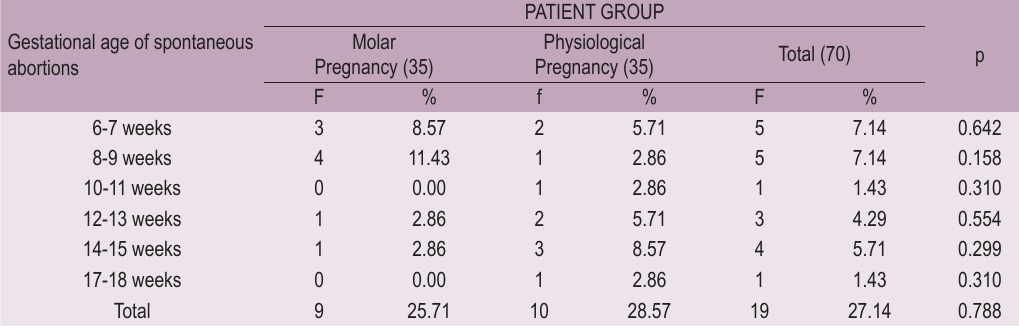
TABLE 4. Number and characteristics of patients according to number and gestational age of spontaneous abortions